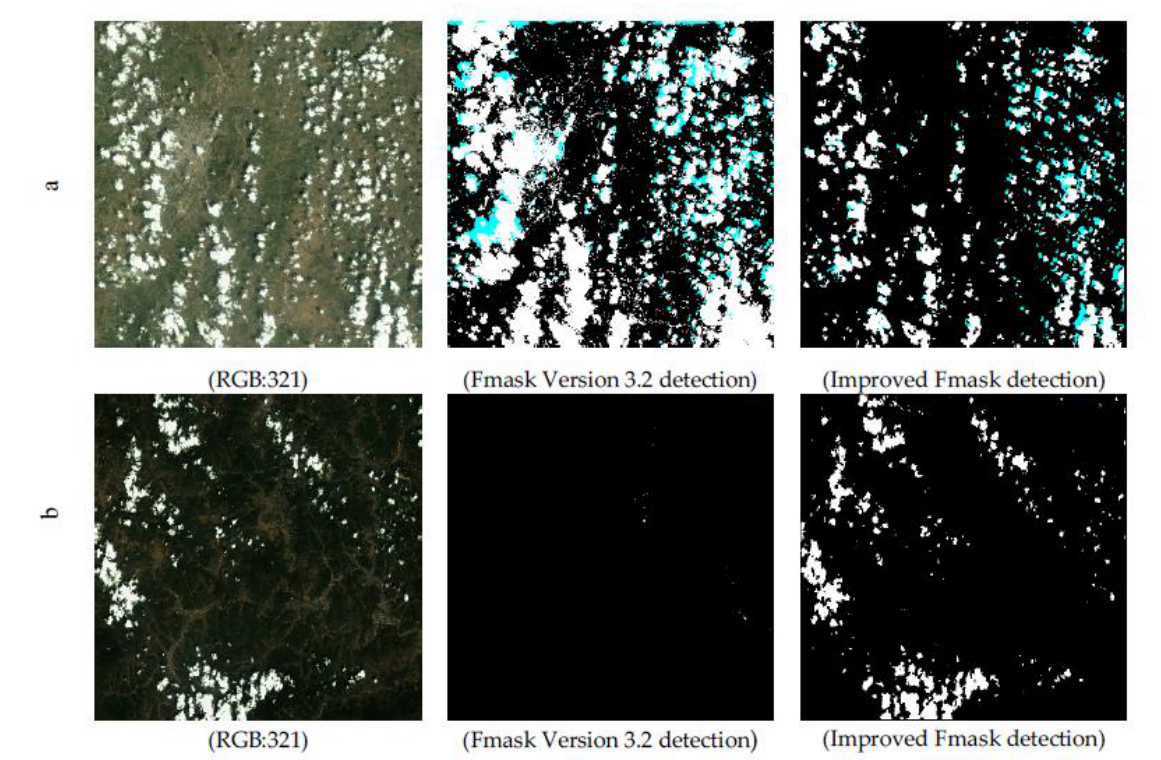
Figure 7. Comparison of detection results between Fmask version 3.2 and the improved Fmask algorithm. ( a ) (Bands 3, 2, and 1 composite) and ( b ) (Bands 3, 2, and 1 composite) are images of different regions of GF-6 WFV data, respectively (The first image in each row). The second and third images in each row show the results of testing the same data by Fmask vesion 3.2 and improved Fmask. The white represents the detected cloud, the black represents the background, and the blue represents the detected cloud shadow.